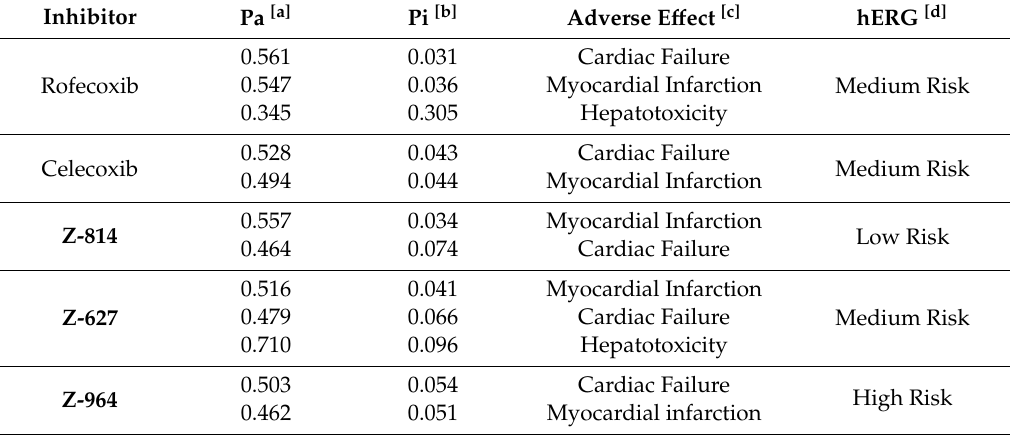
Table 11. Cardiotoxic e ff ects of selected molecules.